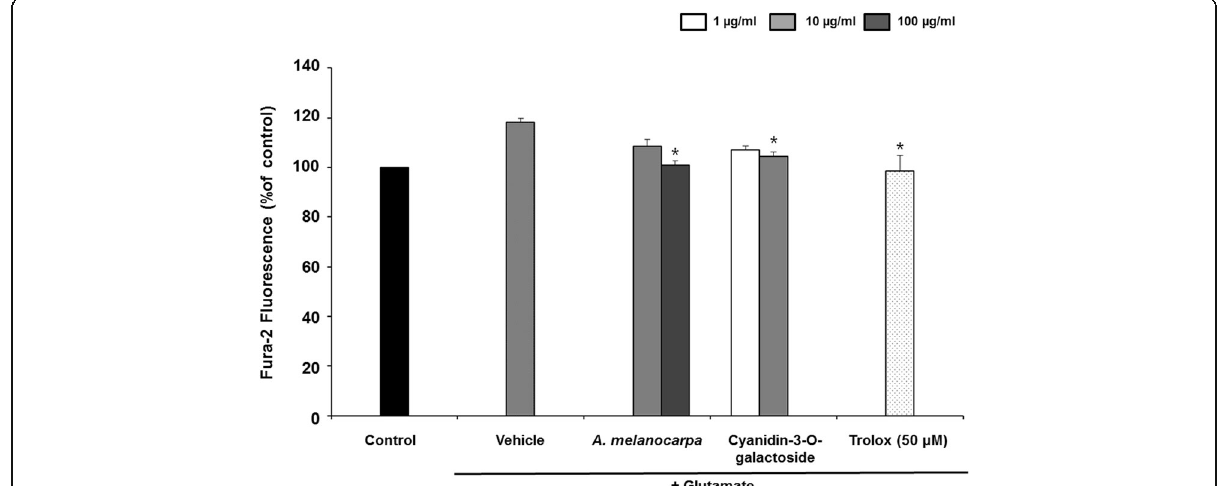
Fig. 3 Effect of A. melanocarpa extract (10 and 100 μ g/ml) and cyanidin-3-O-galactoside (1 and 10 μ g/ml) on Ca 2+ influx in HT22 cells. Data are means ± S.D. * p < 0.05 versus the glutamate-treated group